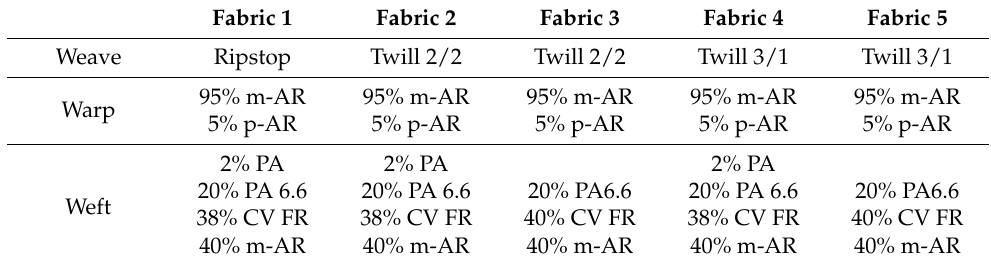
Table 1. Composition of